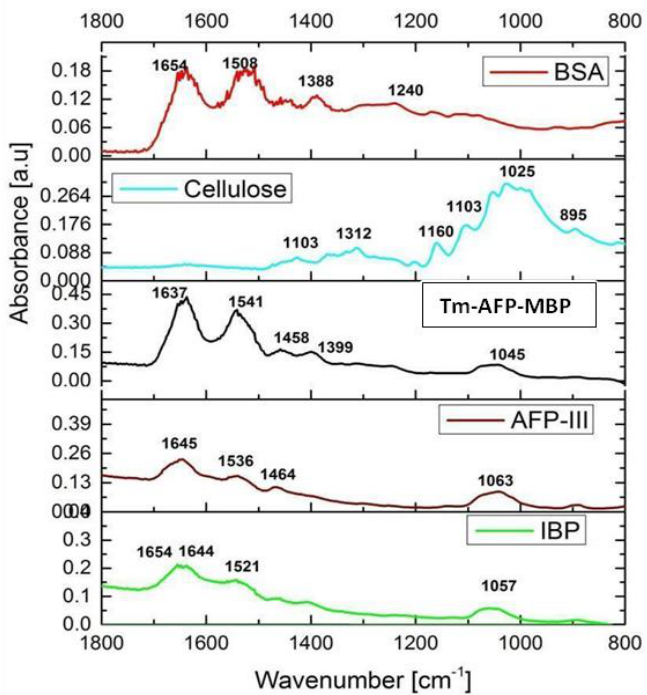
Figure 6. Fourier-transform infrared spectra of the samples between the 1800 and 800 cm − 1 spectral region. The acronyms used in the figure title: Bovine serum albumin (BSA), Tenebrio molitor antifreeze protein-maltose binding protein chimera ( Tm AFP - MBP), type III fish antifreeze protein (QAE-AFP-III), and the current article purified ice-binding protein (IBP).